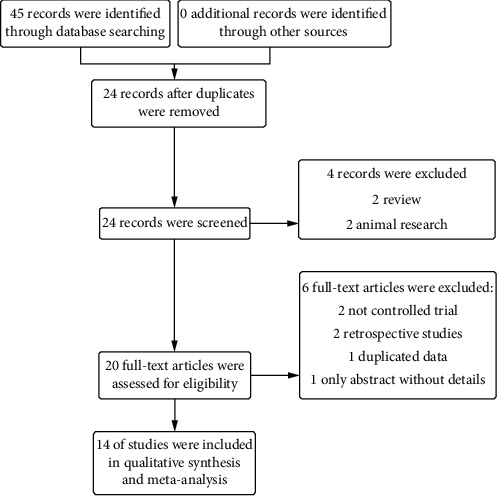
Search and selection of clinical trials assessing the efficacy and safety of ADI on advanced BC.